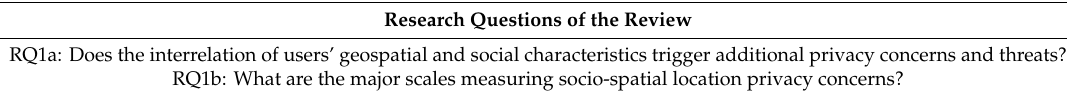
Table 3. Research Questions of the Review.